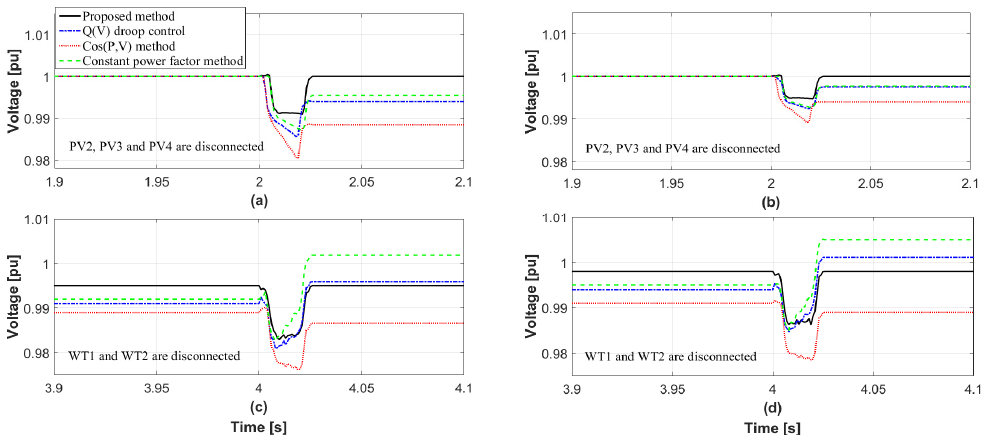
Figure 13. Total load changes of the “Y” substation.